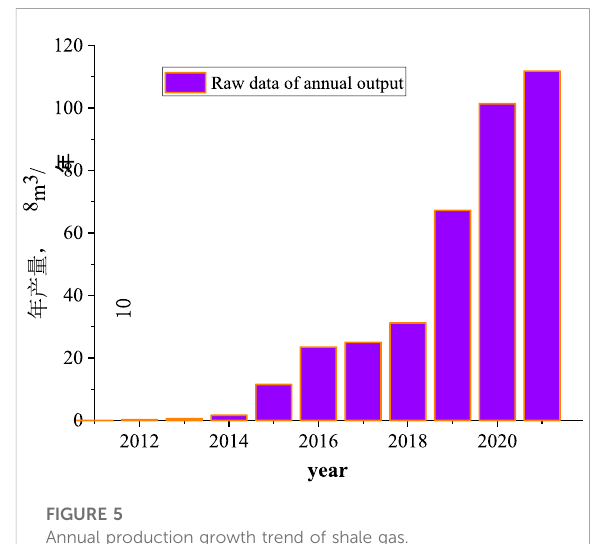
FIGURE 5 Annual production growth trend of shale